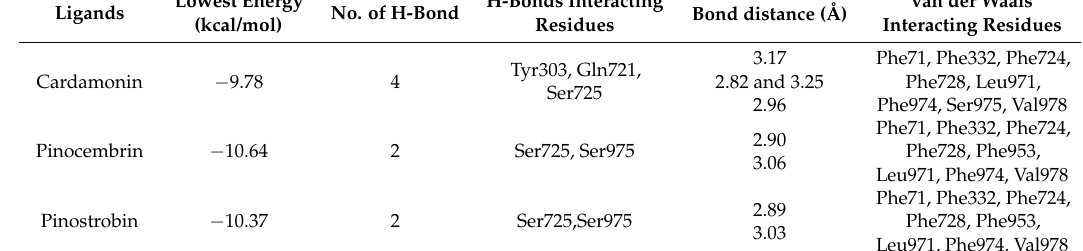
cardamonin, pinocembrin, and pinostrobin with P-glycoprotein (P-gp).